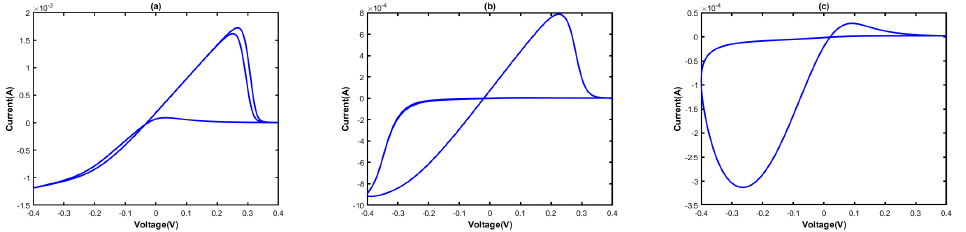
Figure 16. Pinched hysteresis loops for temperatures and process corners, for 45 nm: ( a ) − 40 ◦ C, ( b ) 27 ◦ C, and ( c ) 80 ◦